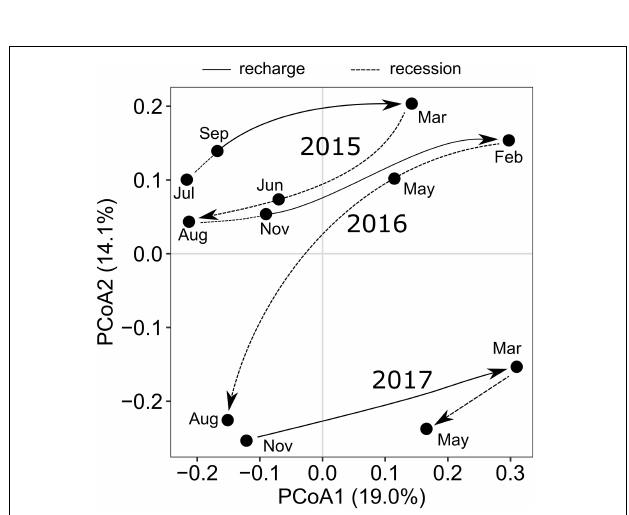
FIGURE 7 | Principal coordinates analysis (PCoA) graph based on Bray-Curtis dissimilarity, summarizing the bacterial community composition in well H41 over 3 years of recharge and recession